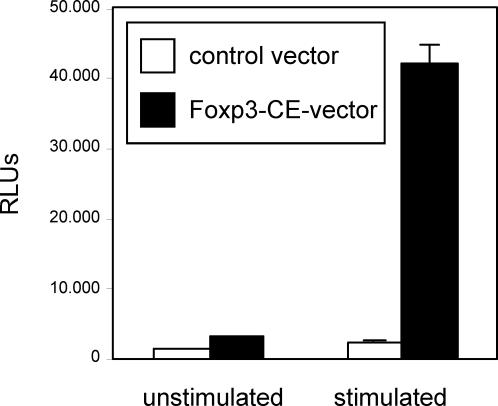
Differentially Methylated, Conserved Element of the foxp3 Locus Possesses Transcriptional ActivityRLM-11–1 cells were transfected with control vector (pGL3 promoter) or Foxp3-CE vector containing the conserved element (CE). Cells were stimulated with PMA for 24 h. Control cells were left unstimulated. Results given are relative luciferase light units (RLUs) normalized for Renilla luciferase activity (mean ± standard deviation; n = 3). Results are representative for two independent experiments.